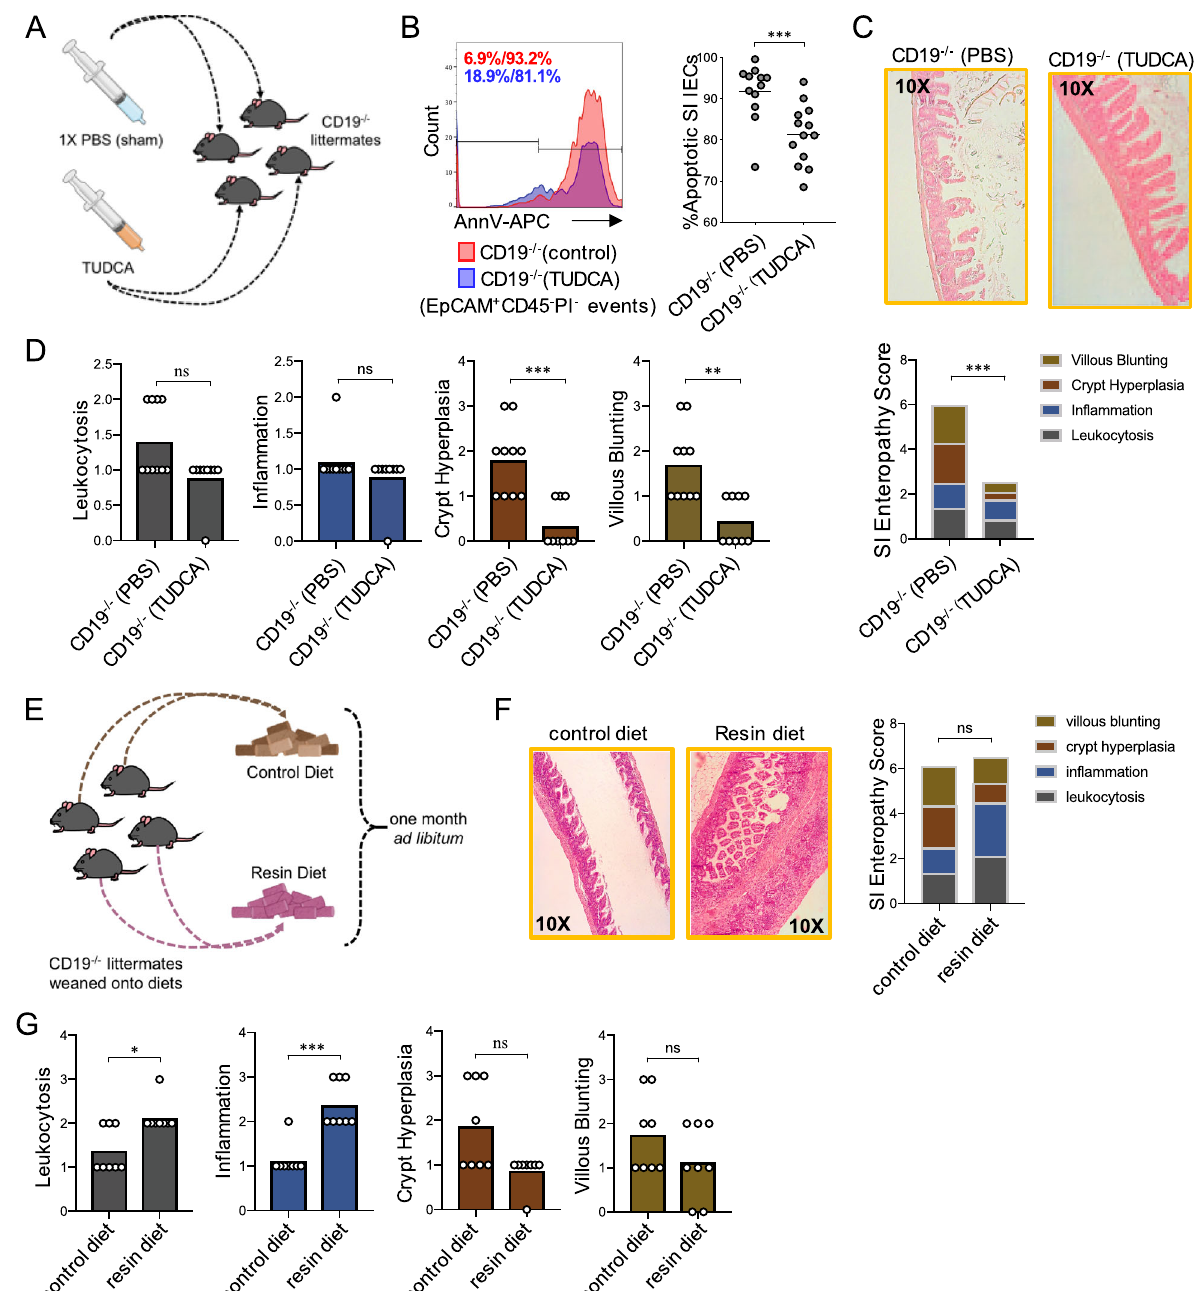
Fig. 4 Manipulation of BA availability alters severity of SI enteropathy. A Schematic overview of oral TUDCA supplementation experiment. Syringe illustrations in ( A ) are image elements derived from BioRender.com. B Representative fl ow cytometry plots and comparison of the percentage of apoptotic IECs in vehicle (PBS) ( n = 12) or TUDCA-treated ( n = 13) CD19 − / − mice are shown. Two-tailed unpaired Mann – Whitney U test; *** = p = 0.0009. C SI enteropathy scoring is shown for vehicle or TUDCA-treated CD19 − / − mice. Two-tailed unpaired Mann – Whitney U test; *** = p = 0.0008. D Comparison of individual features of SI enteropathy between vehicle or TUDCA-treated CD19 − / − mice are shown. Two-tailed unpaired Mann – Whitney U test; (leukocytosis), n = non-signi fi cant = p = 0.0542, (in fl ammation), ns = non-signi fi cant = p = 0.53, ** = p = 0.003, *** = p = 0.0008. E Schematic overview of cholestyramine diet exposure experiment. Mouse chow illustrations in ( E ) are image elements derived from BioRender.com. F Results of SI enteropathy scoring are shown for CD19 − / − mice exposed to control versus resin diet. Two-tailed unpaired Mann – Whitney U test; ns = non-signi fi cant = p = 0.66. G Comparison of individual features of SI enteropathy between CD19 − / − mice exposed to control versus resin diet are shown. Two-tailed unpaired Mann – Whitney U test; (crypt hyperplasia), ns = non-signi fi cant = p = 0.0513, (villous blunting), ns = non-signi fi cant = p = 0.27, * = p = 0.0.02, *** = p < 0.0009. A – D Data representative of three replicate experiments. E – G Data representative of two replicate Bacilli in CD19 − / − mice receiving WT B cells (Fig. 5G). Bacilli abundance was again the only microbial feature we observed to be positively associated (Pearson r) with ileal BA concentrations,